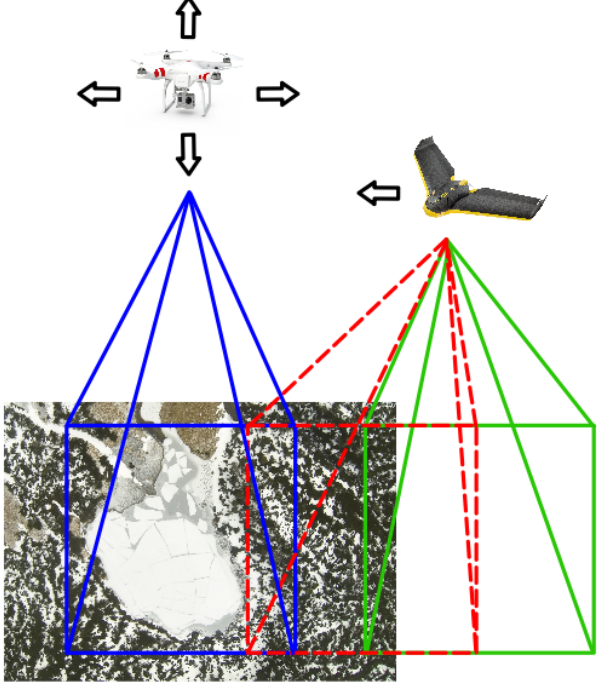
Figure 3. Movement of the quadrocopter and fixed-wing UAS.